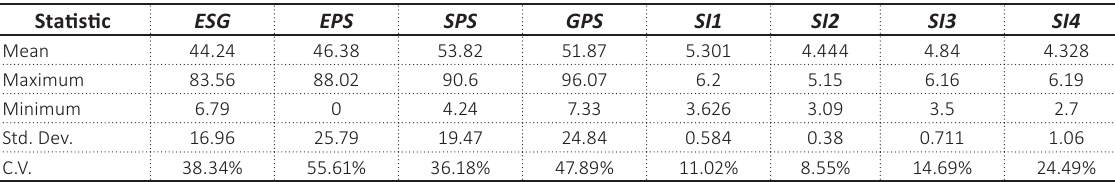
Table 1. Summary